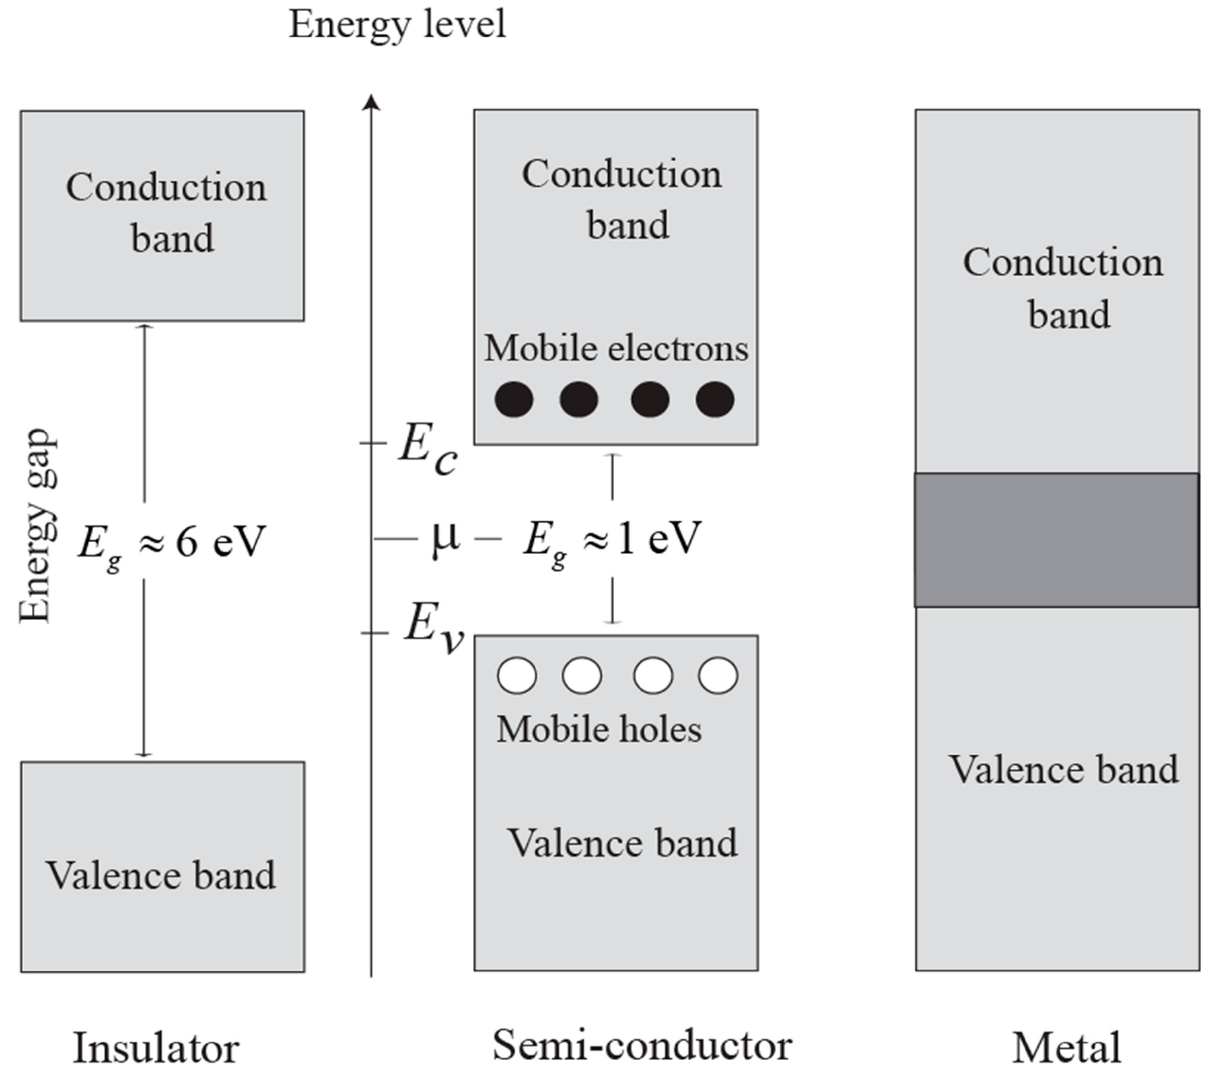
Figure 8. Conduction band, valence band, and the energy gap in an insulator, a semiconductor, and a metal. The distinction between insulators and semiconductors resides in the value of the energy-band gap ( E g ). The energy band denotes the region of discrete energy levels with very close spacings. Electrons and positive holes in the energy gap can be considered as low-density particle ensembles, such as in an ideal electrolyte. These energy levels can be treated as ions in an electrolyte, or as particles in a box (Fermi gas model). In an intrinsic semiconductor (no impurities), the concentrations of the charge carriers depend on the energy gap from the chemical potential ( µ ), which itself corresponds to the Fermi level (in the middle between the conduction ( E C ) and valence ( E v ) energy bands). Modified from [64].